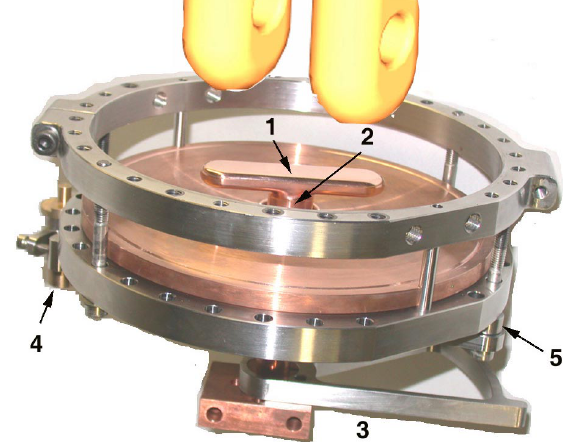
peak).FIG. 6. (Color) Mechanical design of rotary tuner: 1—flat bar with rounded edges; 2—tuner shaft; 3—arc lever arm; 4— driving rotary shaft; 5—coarse tuning